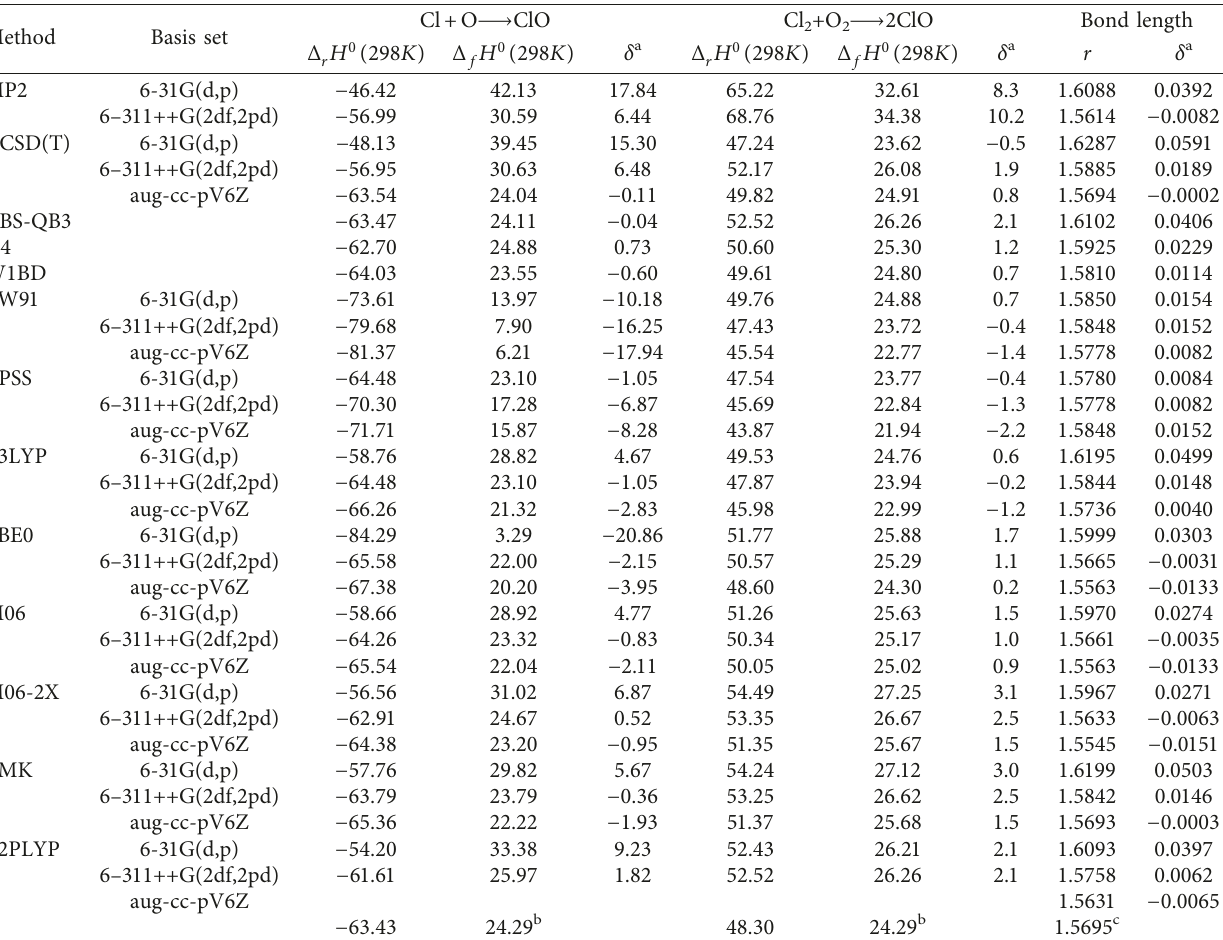
Table 1: Enthalpy of reaction for reactions (1) and (2) and enthalpy of formation of ClO derived from these reactions using different models (in kcal/mol) and ClO bond length (in ˚A).